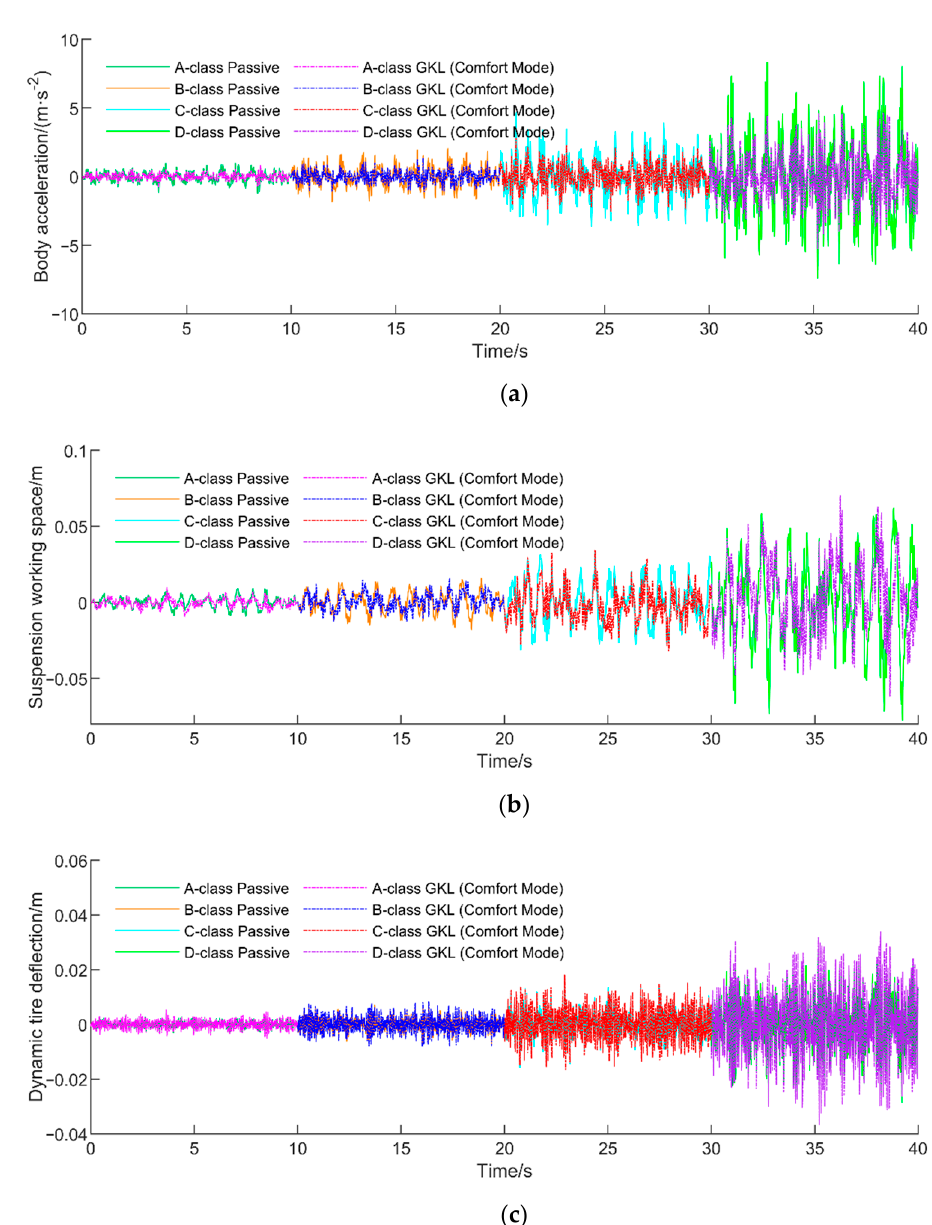
Figure 14. Comparison curves of time domain response for two suspensions (passive suspension and comfort mode of active suspension: ( a ) BA; ( b ) SWS; ( c ) DTD. Table 15. RMS values and improvement rate of performance indexes for comfort mode.